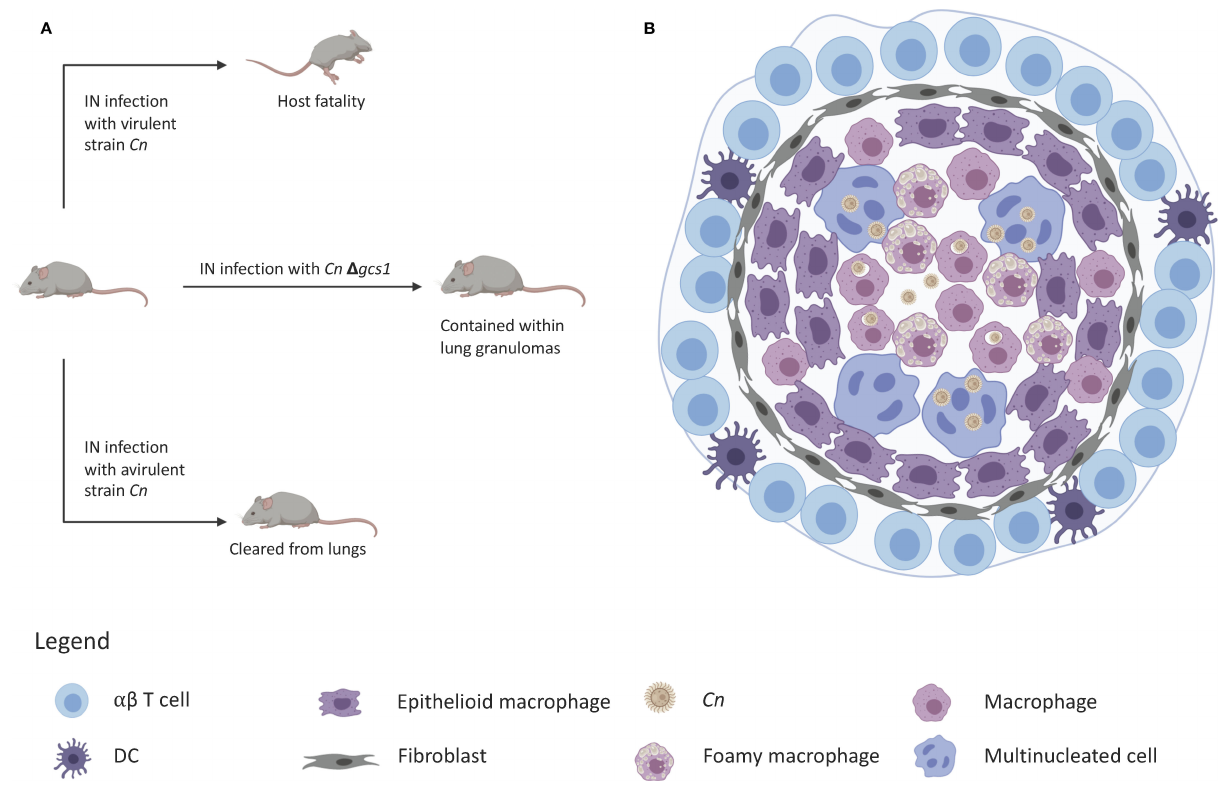
FIGURE 2 | Granuloma containment in mice infected with C. neoformans △ gcs1 . (A) Mice are notorious for lacking the ability to form lung granulomas to contain C. neoformans infection. Infection with a virulent strain results in death and infection with an avirulent strain leads to clearance of the yeast from the lungs. Infection with C. neoformans △ gcs1 results in granuloma containment of the yeast in the mouse lungs. (B) These granulomas exhibit a slightly necrotic center with macrophages, foamy cells, and giant multinucleated cells with internalized C. neoformans . These cells are surrounded by a closure of epithelioid cells and fibroblasts, followed by an outer ring of